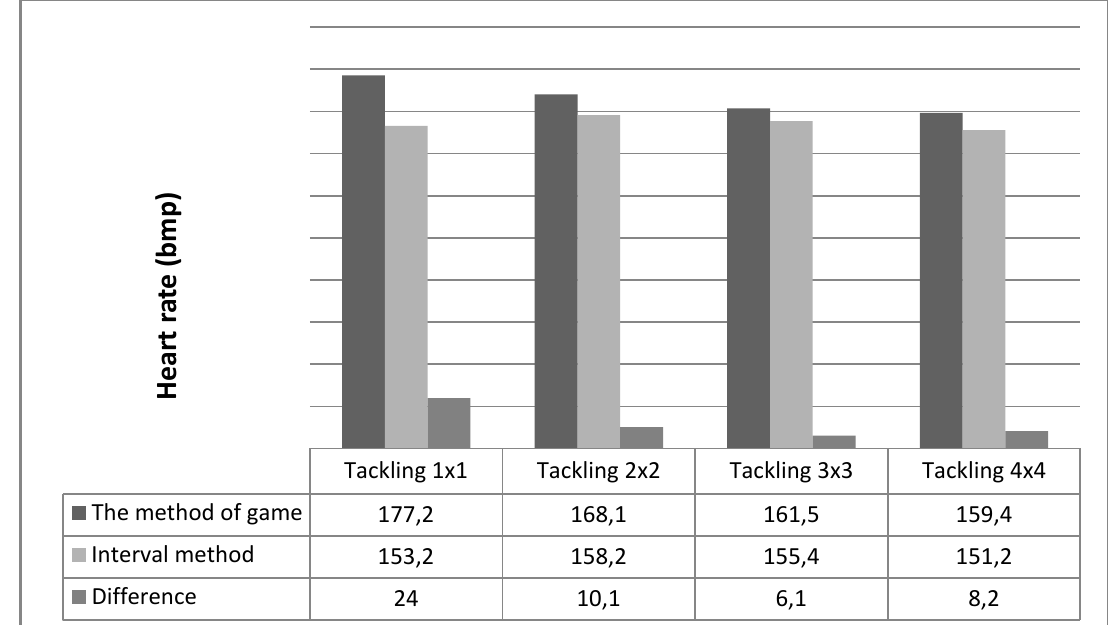
Fig.1. Dynamic of HBR with fulfillment of tackling by different methods (b.p.m.)